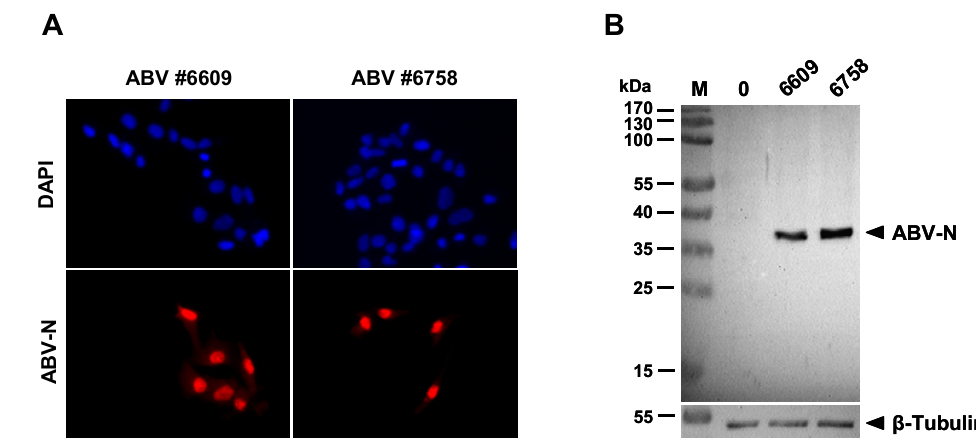
Figure 1. Rabbit antiserum specifically detecting the N protein of ABV in infected cells. (A) Indirect immunofluorescence analysis of QM-7 cells infected with ABV strains #6758 or #6609. Persistently infected and uninfected QM-7 cells were mixed at an initial ratio of 1:20 before plating. After overnight growth, the cultures were stained with antiserum (red) to visualize infected cells. DAPI (blue) was used for counter-staining. (B) Western blot analysis of lysates derived from QM-7 cells persistently infected with ABV strains #6758 or #6609. Uninfected QM-7 cells (0) served as controls. Pre-stained marker proteins (M) served as size